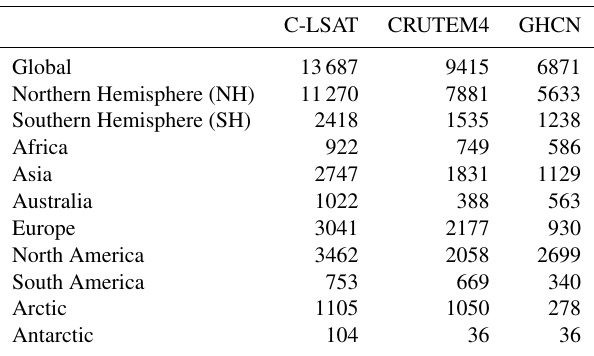
Table 1. Comparison of the station number of the LSAT dataset during 1900–2017 (data length > 15